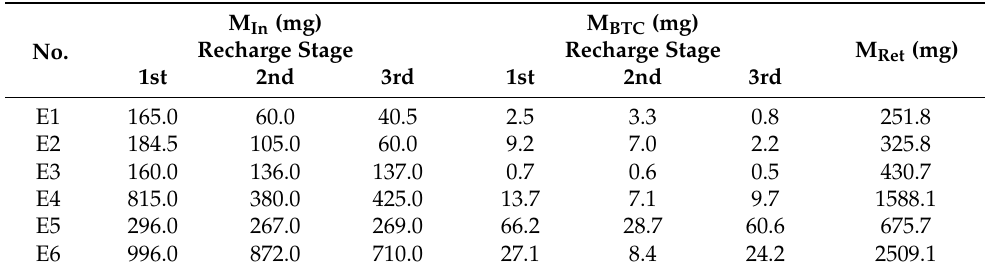
Figure 3. Cumulative mass distribution of pollutants in media with different particle sizes. ( a ) E1 and E2 (Fe); ( b ) E3 + E4 (Zn); ( c ) E5 + E6 (Pb). Table 4. Mass balance information from the column experiment. Here, M In denotes the injection mass of pollutant; M BTC and M Ret denote the mass of the injection pollutant that was recovered in the breakthrough curve and retained in the sand column, respectively.